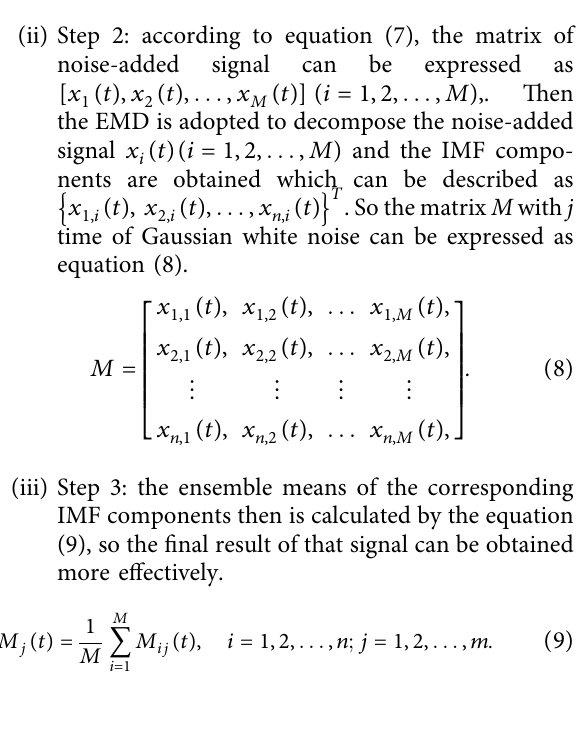
Figure 2: Decomposing process of